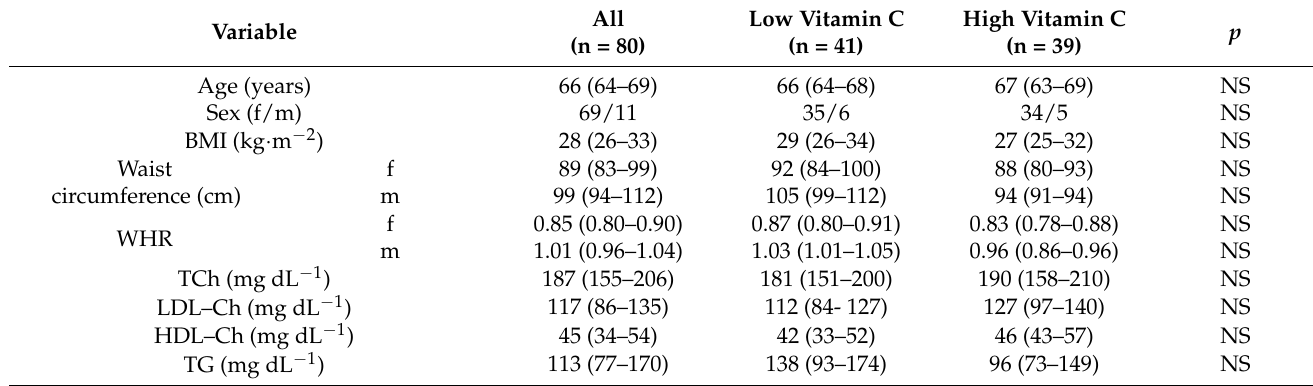
Table 1. Baseline characteristics of the study groups.